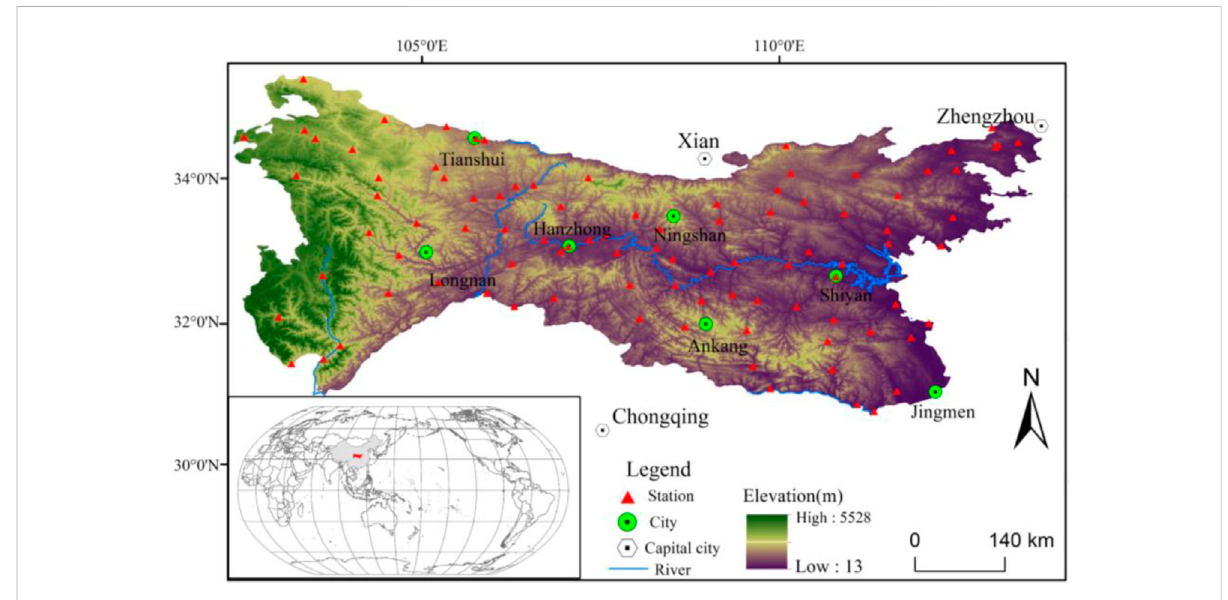
FIGURE 1 Distribution map of Qinba Mountains meteorological